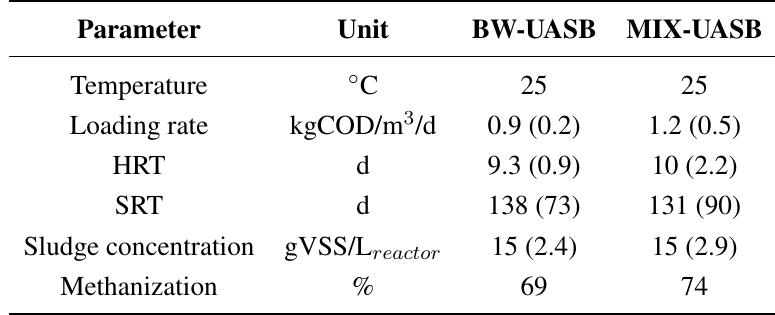
Table 2. Operational conditions and methanization of the UASB reactors at steady state. HRT, hydraulic retention time; SRT, sludge retention